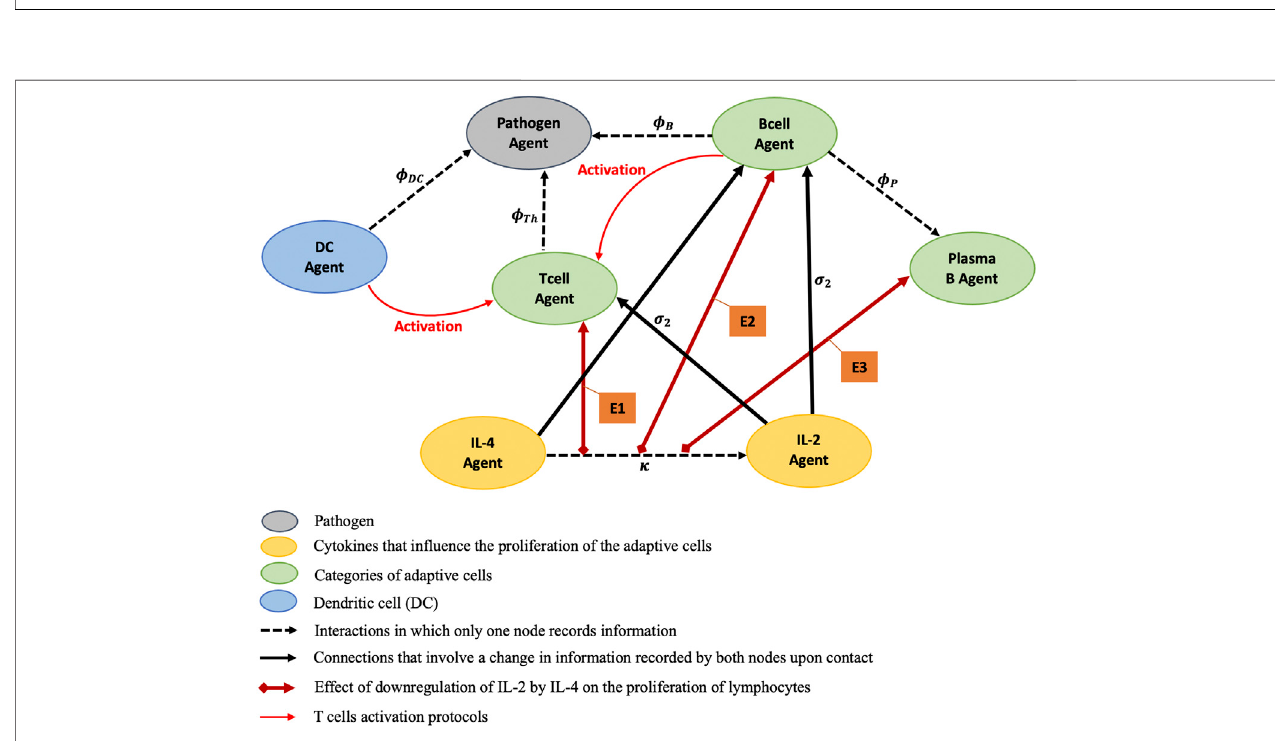
FIGURE2| Staticportrayalofagentsandinteractionsofanadaptiveimmuneresponsenetwork.E1,E2,andE3standformodelingeffectsofthedownregulationof IL-2 by IL-4 on the proliferations of T cell Agent, B cell Agent, and Plasma B cell Agent respectively. The red lines encode the T cell activation protocols controlled by DC andBcellAgents.TheTcellsproliferateatrates σ 2 ,andbecomeactivatedwithrates ϕ Th asThelpercells.TheBcellsproliferateandbecomeactivatedwithrates σ 2 ,and ϕ ϕ B respectively. B cells differentiate into plasma B cells at a rate of P . On activation, the dendritic cell matures into a highly effective antigen presenting cell (APC) andundergoeschangesthatenableittoactivateTcellsencounteredinthelymphnodewithactivationrate ϕ DC .ThedownregulationofIL-2byIL-4isprocessedwithrate parameter κ .